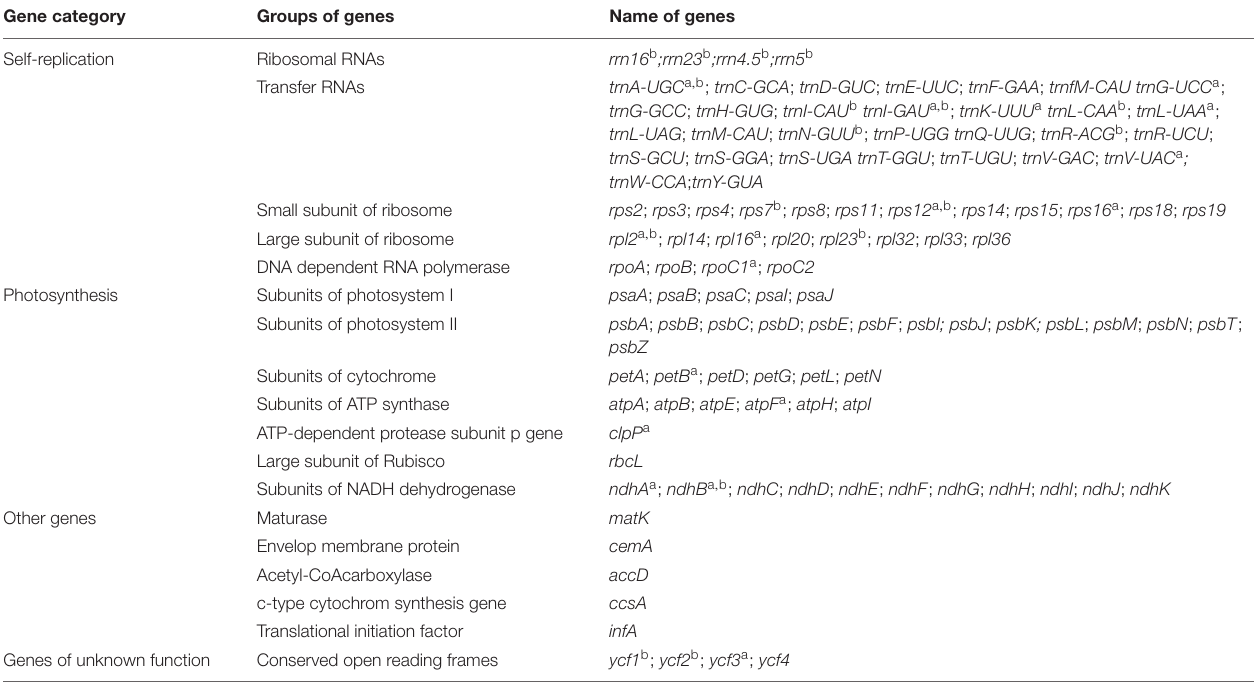
TABLE 2 | Genes contained in the chloroplast genome sequence of 25 Zingiberaceae